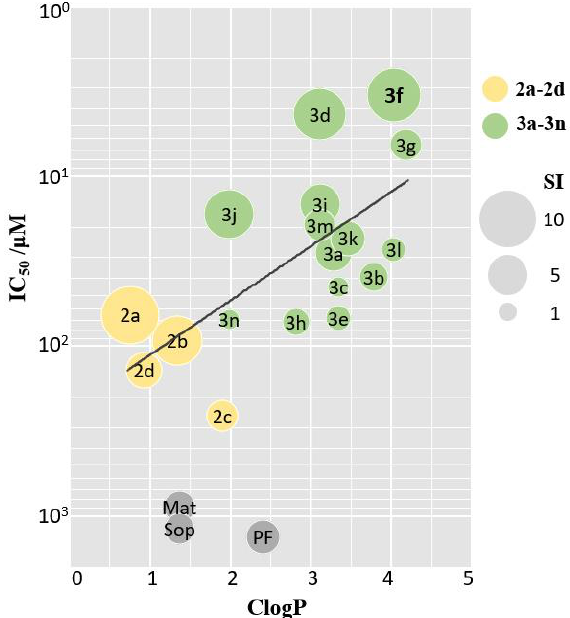
Figure 3. Bubble chart of ClogP-IC 50 . X-axis and Y-axis represents ClogP and IC 50 values, respectively. Bubble size reflects SI value. Yellow, green, and grey bubbles represent derivatives 2a – d , 3a – n , and positive control, respectively. Mat, Sop, PF was abbreviation for Matrine, Sophocarpine, and Pirfenidone, respectively.